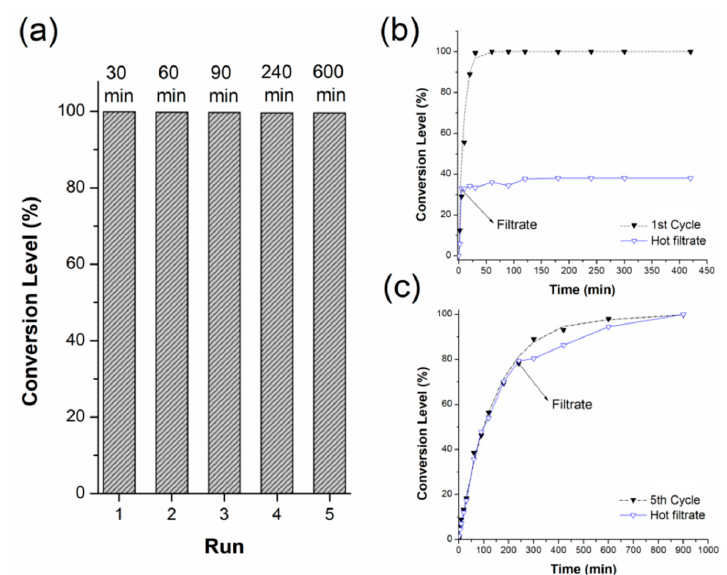
Figure 9. Recycle and hot filtration study for PdAS(10)-MA catalyst in the production of MCIN at 120 °C using DMF as solvent. ( a ) Recycles, ( b ) hot filtration test for the first cycle, and ( c ) hot filtration test for the fifth cycle. Materials 2019 , 12 , x FOR PEER REVIEW 5 of 20